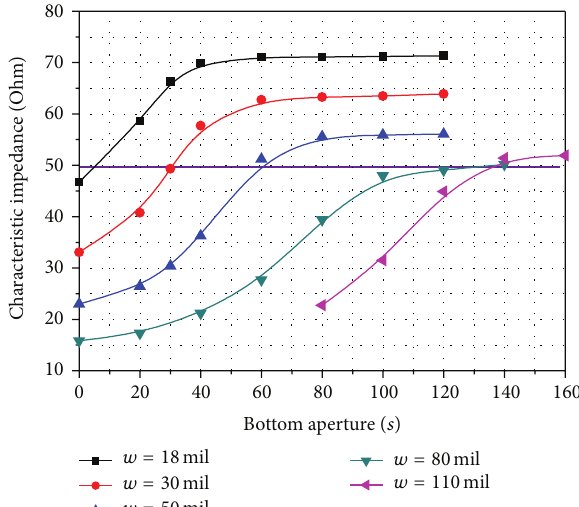
Figure 10: Characteristic impedances of the transition to determine the bottom aperture ( s ).